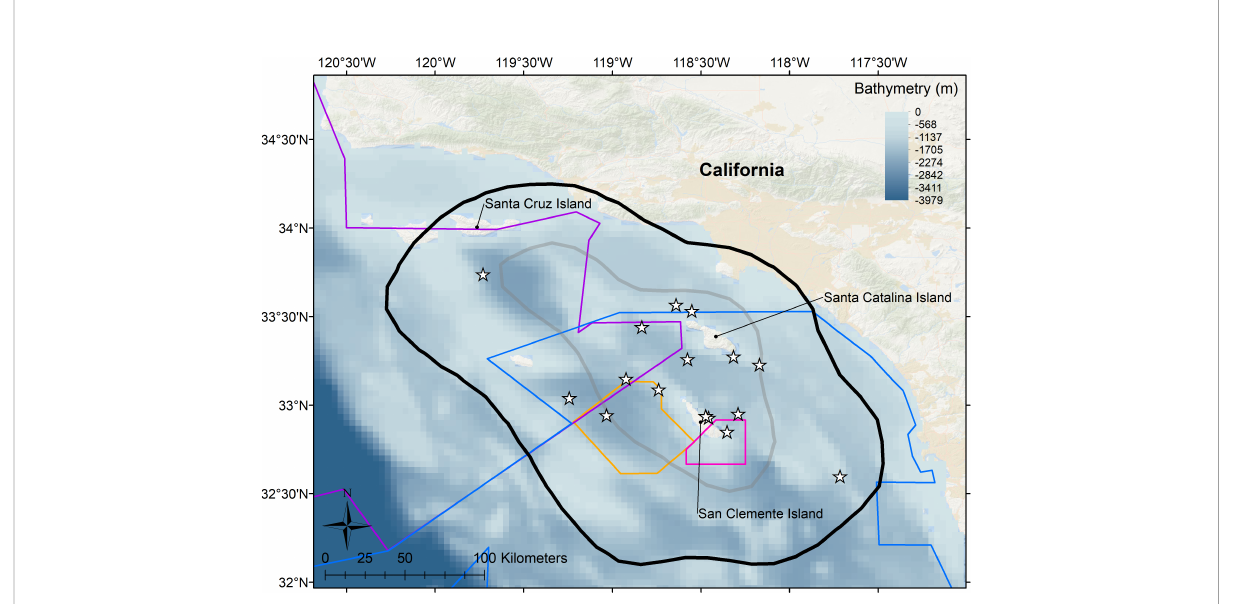
FIGURE 3 Core use areas for 16 Risso ’ s dolphins tagged in the Southern California Bight from 2009 – 2019 as indicated by 50% (gray line) and 95% (black line) kernel density estimates of the combined location data across tags. Stars represent deployment locations. Kernel density isopleths were derived from one average daily position to minimize autocorrelation bias, and are overlayed on high resolution ETOPOv2 bathymetry in meters. Military training ranges are indicated by colored polygons as follows: Blue = Southern California Range Complex; Purple = Point Mugu Sea Range; Orange = Southern California Anti-submarine Warfare Range; Pink = Shore Bombardment